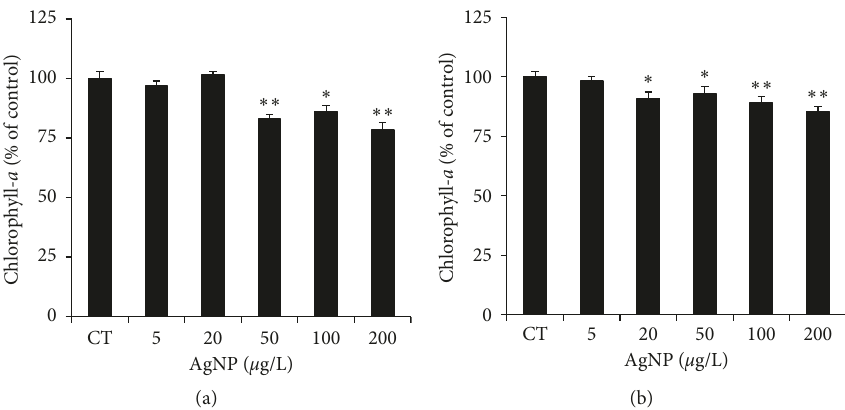
Figure 4: Chlorophyll- a content of (a) Scenedesmus sp. and (b) Thalassiosira sp. upon exposure to silver nanoparticles. Asterisks indicate significant differences compared with the control ( ∗ P < 0 . 05; ∗∗ P < 0 . 01).